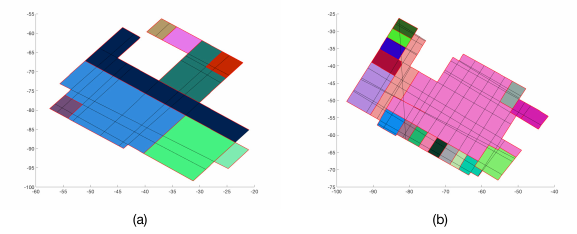
Figure 9. Results of room segmentation (including rooms and corridors): a) office 1 with 9 regions; b) office 2 with 18 regions.